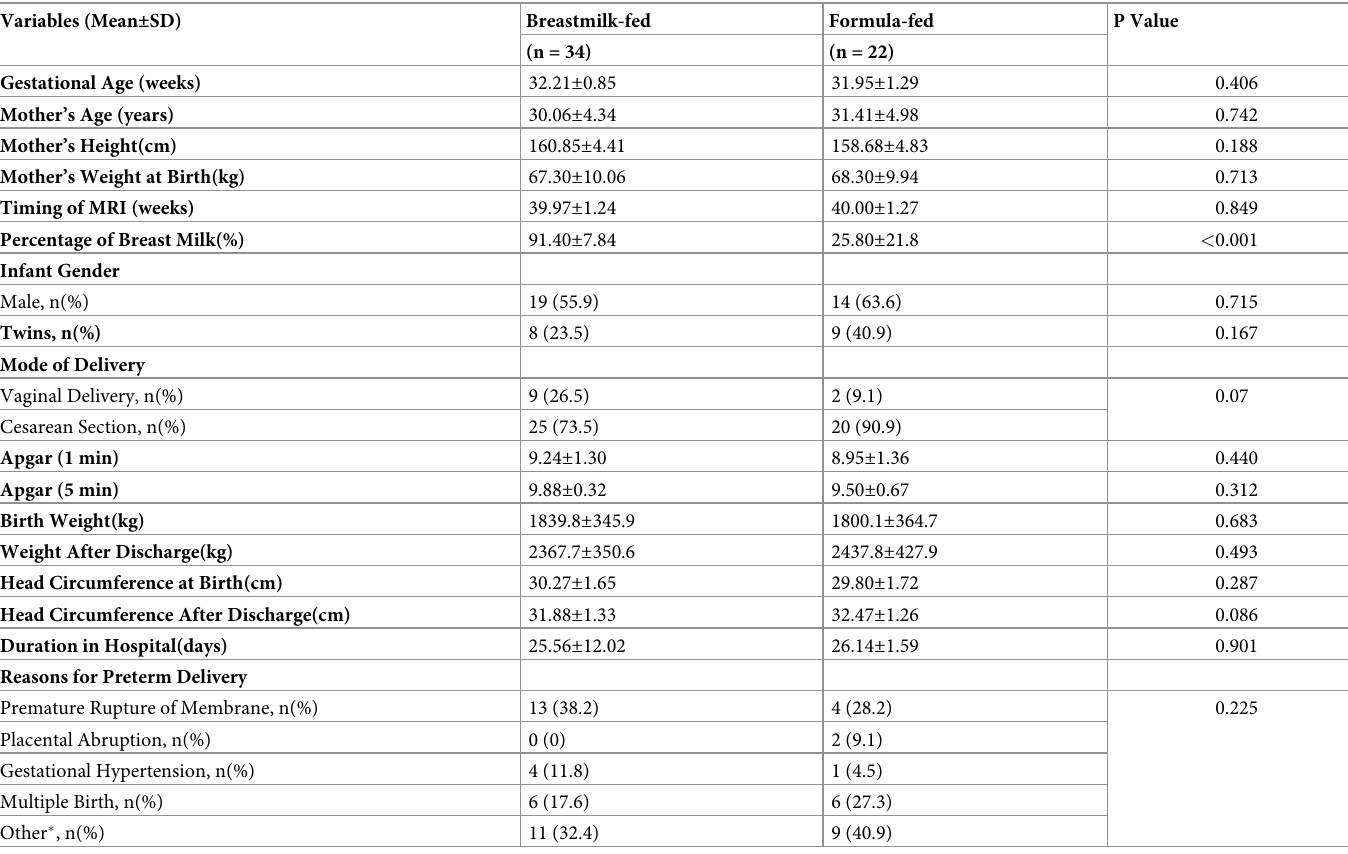
Table 1. Maternal & neonatal demographics.